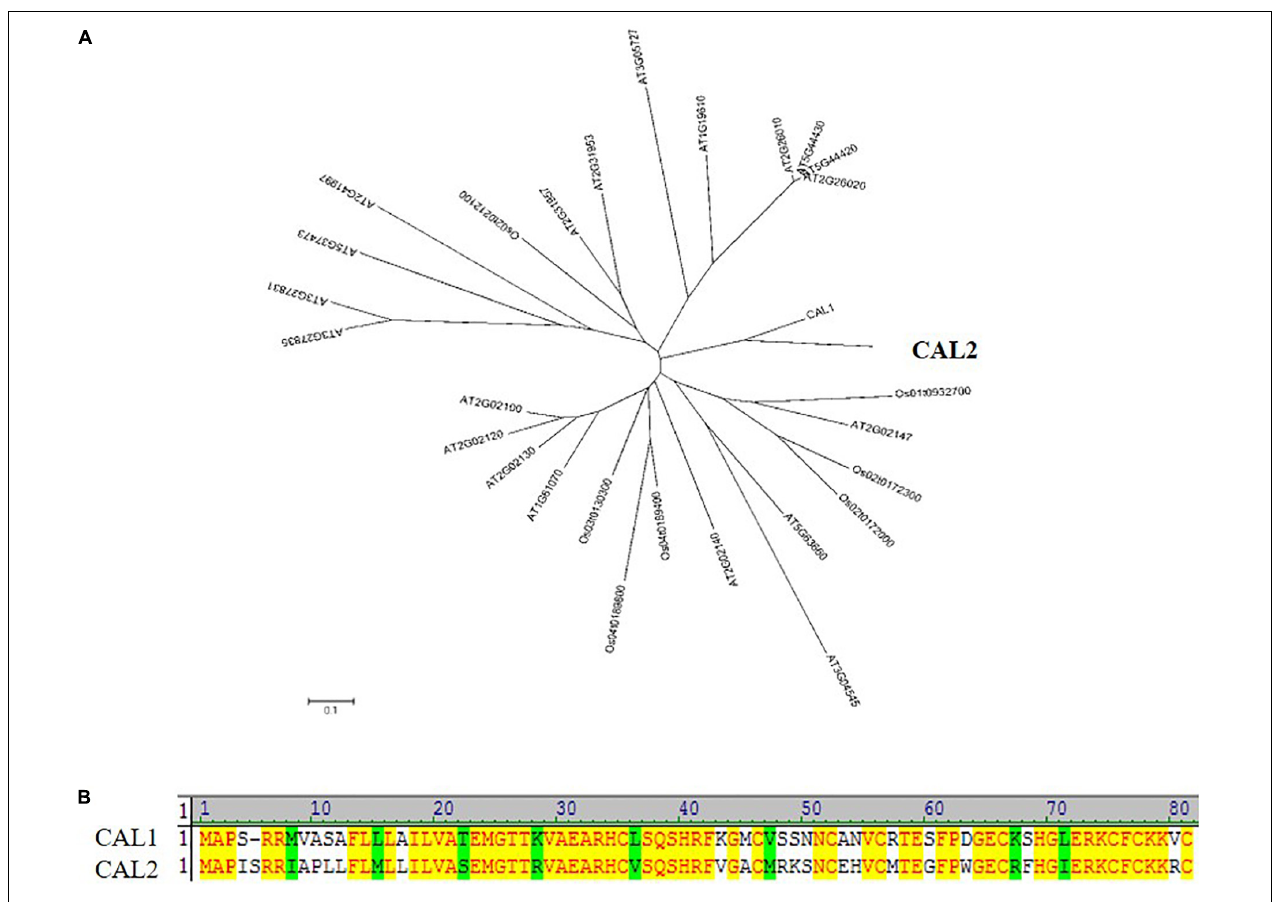
FIGURE 1 | CAL2 is the closest homolog of CAL1. (A) Phylogenetic relationship of defensin proteins in rice and Arabidopsis thaliana . The 0.1 scale shows substitution distance. (B) Alignment of CAL1 and CAL2 proteins.